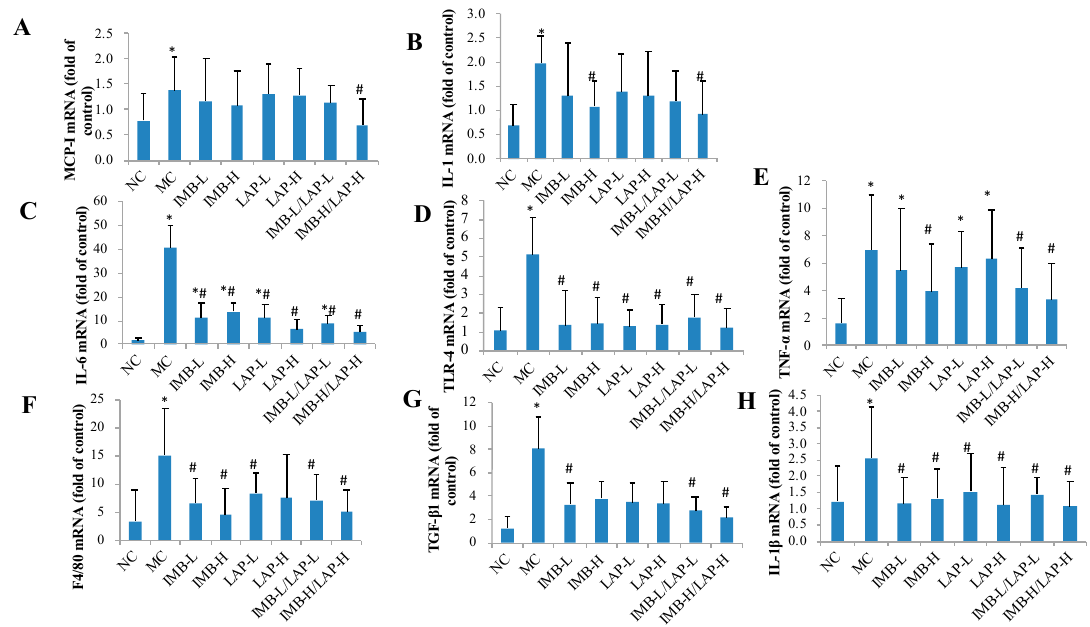
Figure 4. Effects of IMB and LAP supplements on the gene expression levels of inflammatory cytokines in kidney. MCP-1 (A), IL-1 (B), IL-6 (C), TLR-4 (D), TNF- α (E), F4/80 (F), TGF- β 1 (G), and IL-1 β (H). Values are expressed as Mean±SD, n=8. Within each panel, values with the superscript symbols “*” and “#” are significantly different from the NC and MC, respectively, P at least <0.05. 3.5. Effects of IMB and LAP Treatments on the Expression Levels of Stem Cell-Related Genes in Kidney Compared with the NC, the MC showed significantly elevated CD44, CD133, CD11 β , Pax-2, vimentin, Wnt-4, Wt-1, and nestin mRNA levels in kidney (Figure 5, p < 0.05). The treatments with LAP-H and the two combinations ameliorated the imbalance changes of CD44, CD133, CD11 β , and Pax-2 mRNA levels compared with the positive control ( p < 0.05), and the treatments with IMB (low or high dose) and the combination of IMB-H/LAP-H reduced Wt-1 and nestin mRNA levels ( p < 0.05).